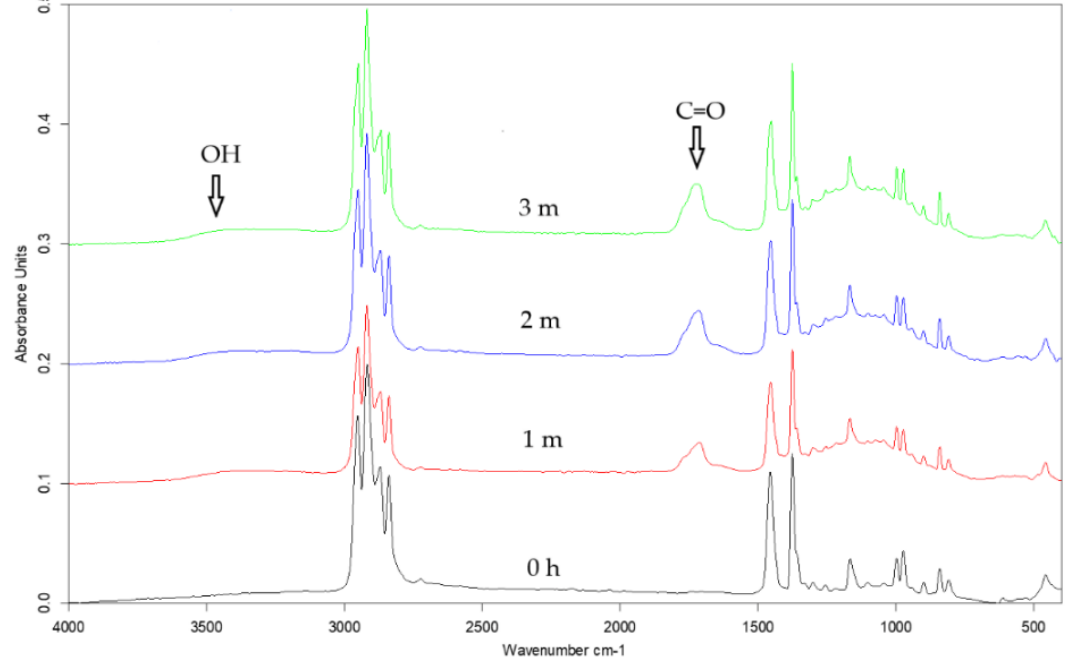
Figure 5. ATR-FTIR spectra of the unoriented i -PP + 5% of glass beads before UV treatment ( black line ), after one-month ( red line ), two-month ( blue line ), and three-month irradiation ( green line ).